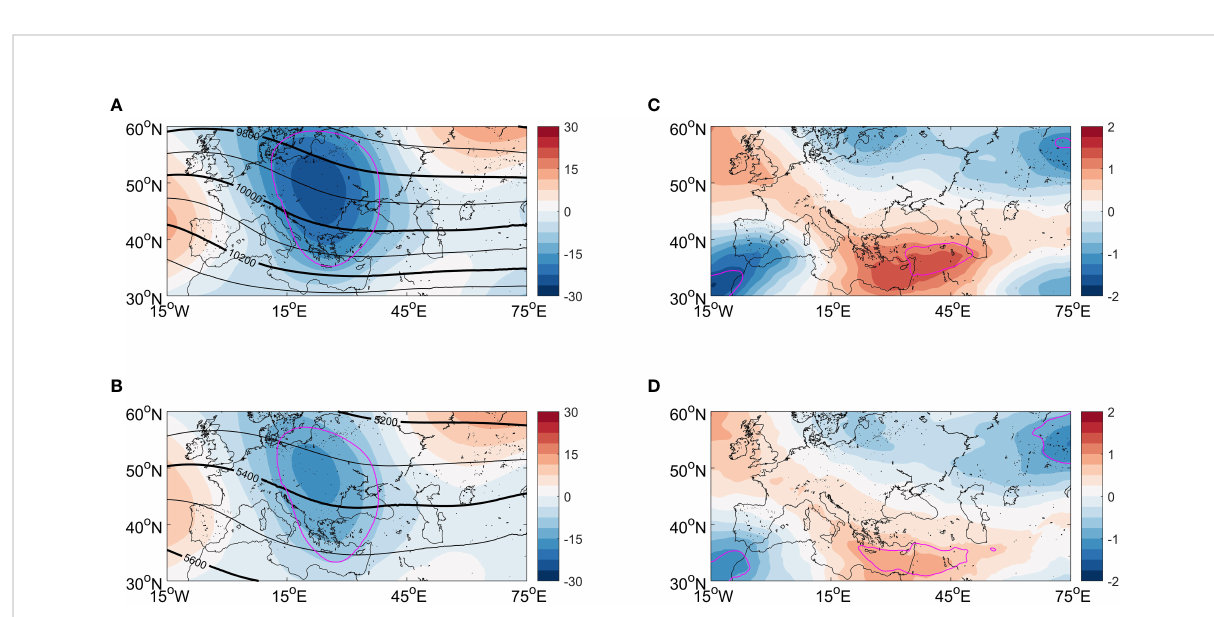
FIGURE 3 The lagged regressions of (A) z 250 (shading; unit, gpm), (B) z 500 (shading; unit, gpm), (C) u 250 (shading; unit, m s − 1 ), and (D) u 500 (shading; unit, m s − 1 ) in DJF onto the KEI 2 month earlier, superposed with the DJF-mean z 250 and z 500 in panels ( A, B ) respectively. Magenta contours represent where the atmospheric responses pass the 90% con fi dence level. KEI, Kuroshio Extension index.